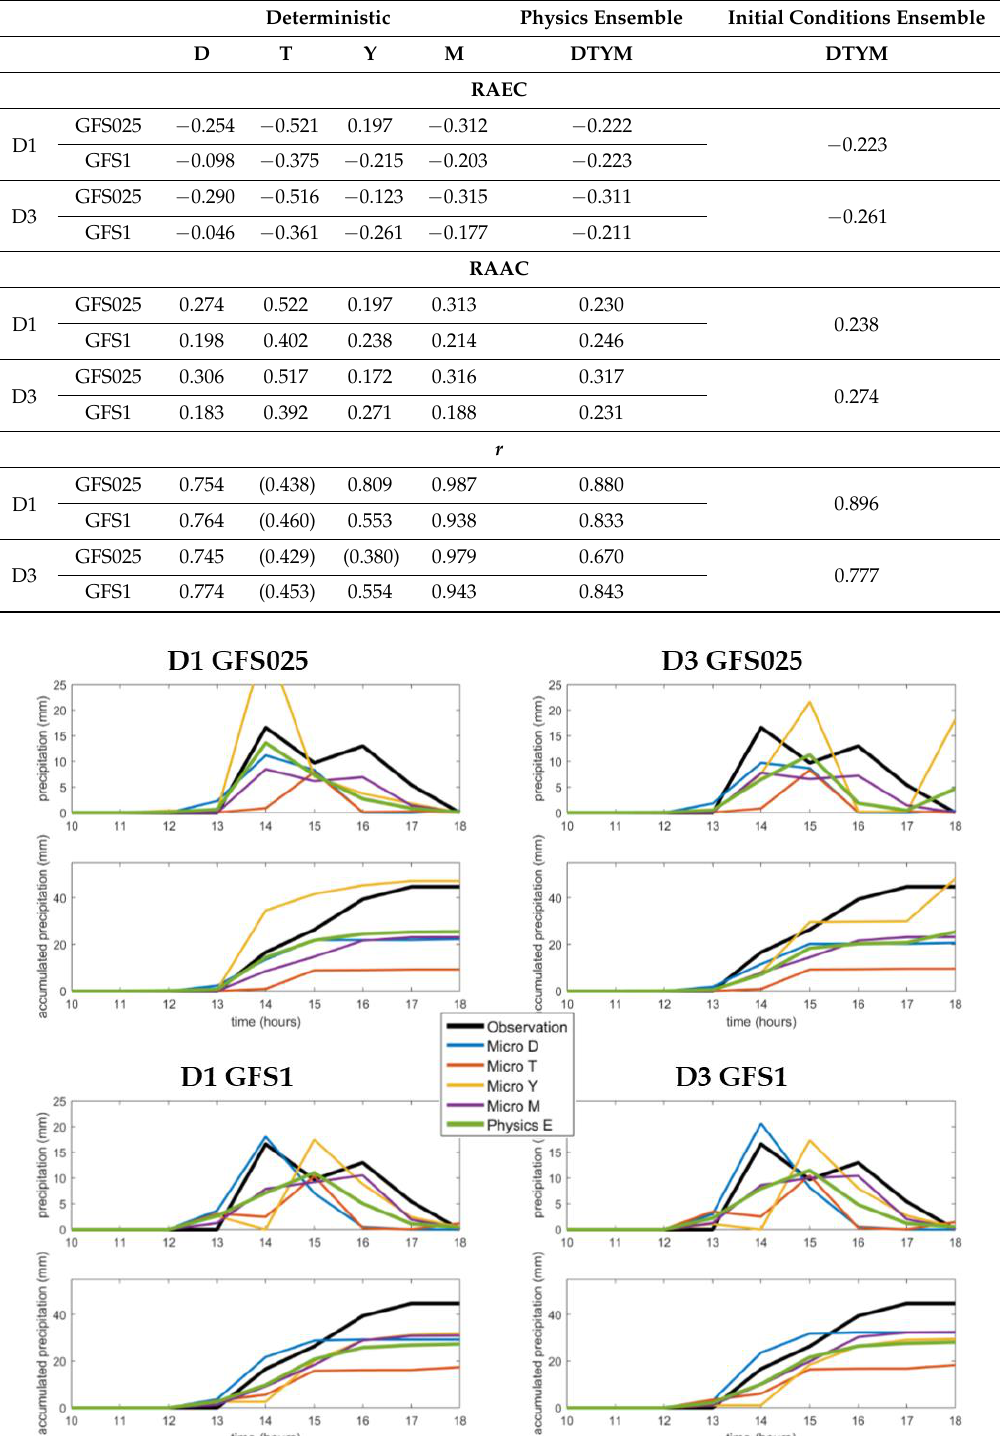
Figure 6. Hourly precipitation (mm, upper panels) and accumulated precipitation (mm, lower panels) between 10:00 and 18:00 UTC for LEMD station. Each deterministic model configuration is shown with the four microphysics schemes, the physics ensemble for each configuration and observed precipitation.